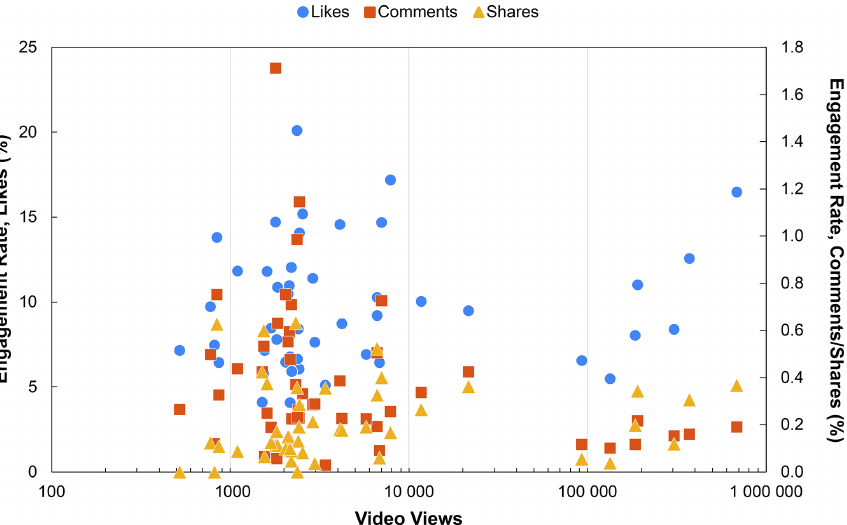
Figure 6. Engagement rate of likes, comments, and shares from each video compared with video views (plotted on a log scale). There is a statistically significant strong positive correlation between the number of video views and the engagement rate of likes for videos with over 90000 views ( r = 0.90, p = 0.006) but no statistically significant correlation between the number of video views and the engagement rate of likes for videos with less than 90000 views ( p > 0.05). There is no statistically significant correlation between the number of video views and the engagement rate of comments or shares ( p > 0.05). See Supplement for full correlation analysis.